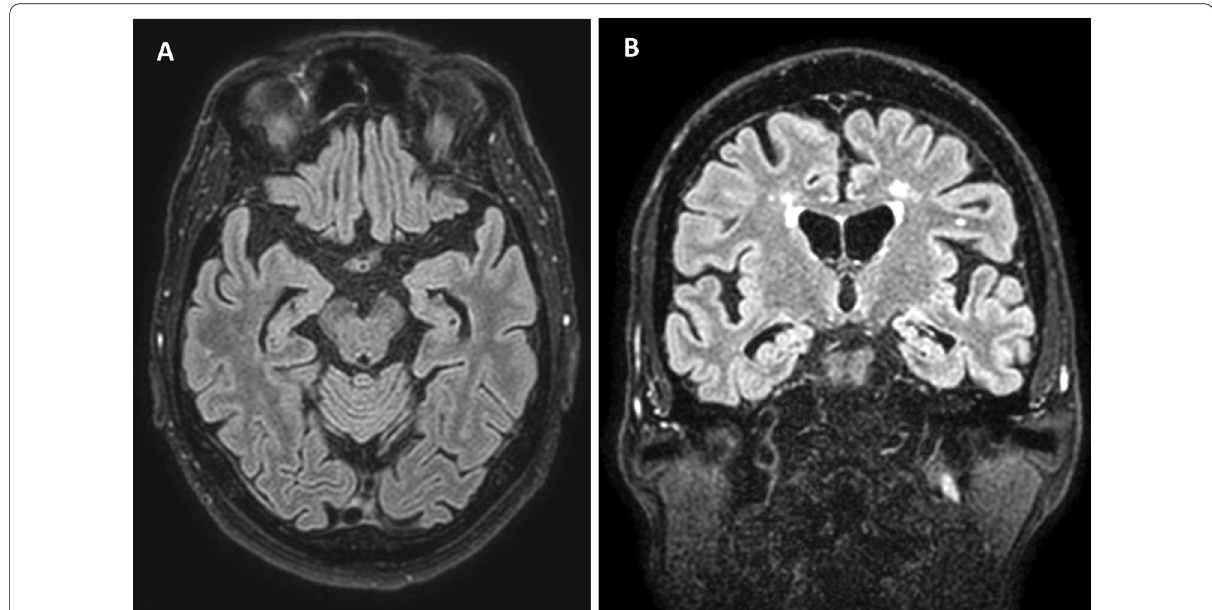
Fig. 2 Cerebral MR imaging showing bilateral hippocampal atrophy and mild global atrophy (Fluid attenuated inversion recovery (FLAIR); A : axial; B :